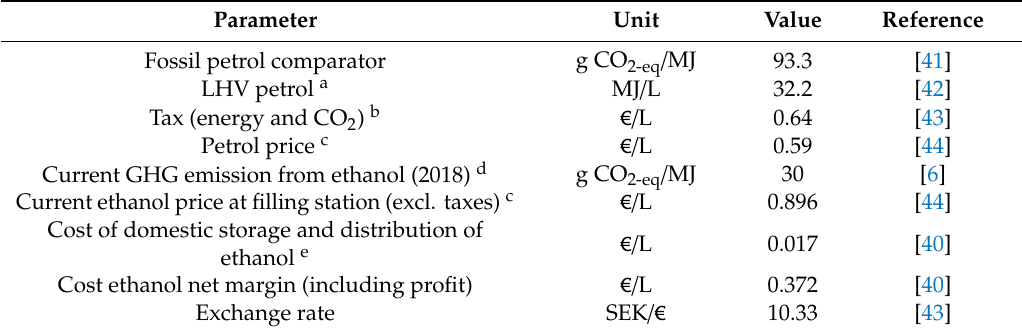
Table 3. Data used for economic calculations in the production of sawdust-based ethanol.